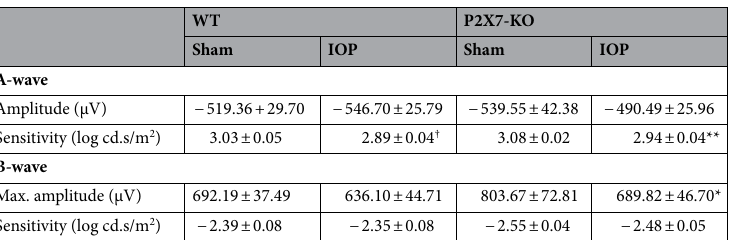
Table 1. ERG measures of a and b-wave amplitude and sensitivity in WT and P2X7R-KO animals. † p = 0.025, **p = 0.0128, *p = 0.0297 compared to sham of the same